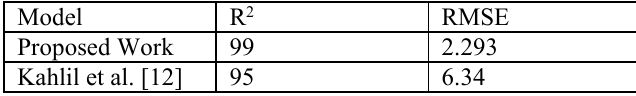
Figure 5. Effects on DC power output (a) influence of Beam Irradiance and Wind Speed, (b) influence of Diffuse Irradiance and Wind